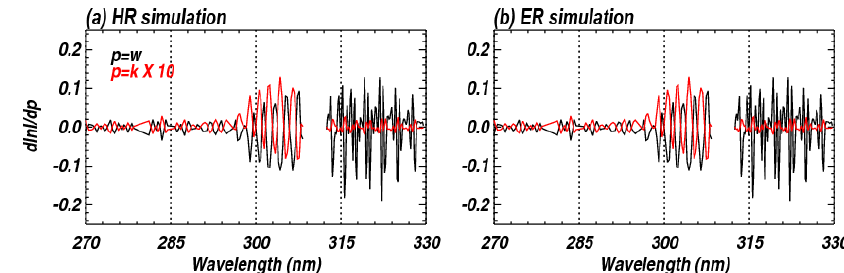
Figure 3. Derivatives of an OMI radiance spectrum simulated using high-resolution (HR) and effective-resolution (ER) cross section spectra with respect to slit parameters assuming a super Gaussian function. dln I/ d k is multiplied by a factor of 10 to visually match dln I/ d w on the same y axis.